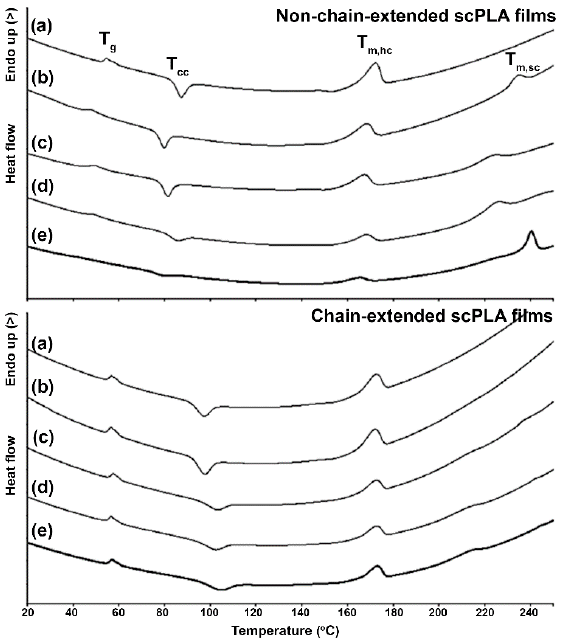
Table 2. Thermal transition properties of stereocomplex polylactide (scPLA) films.